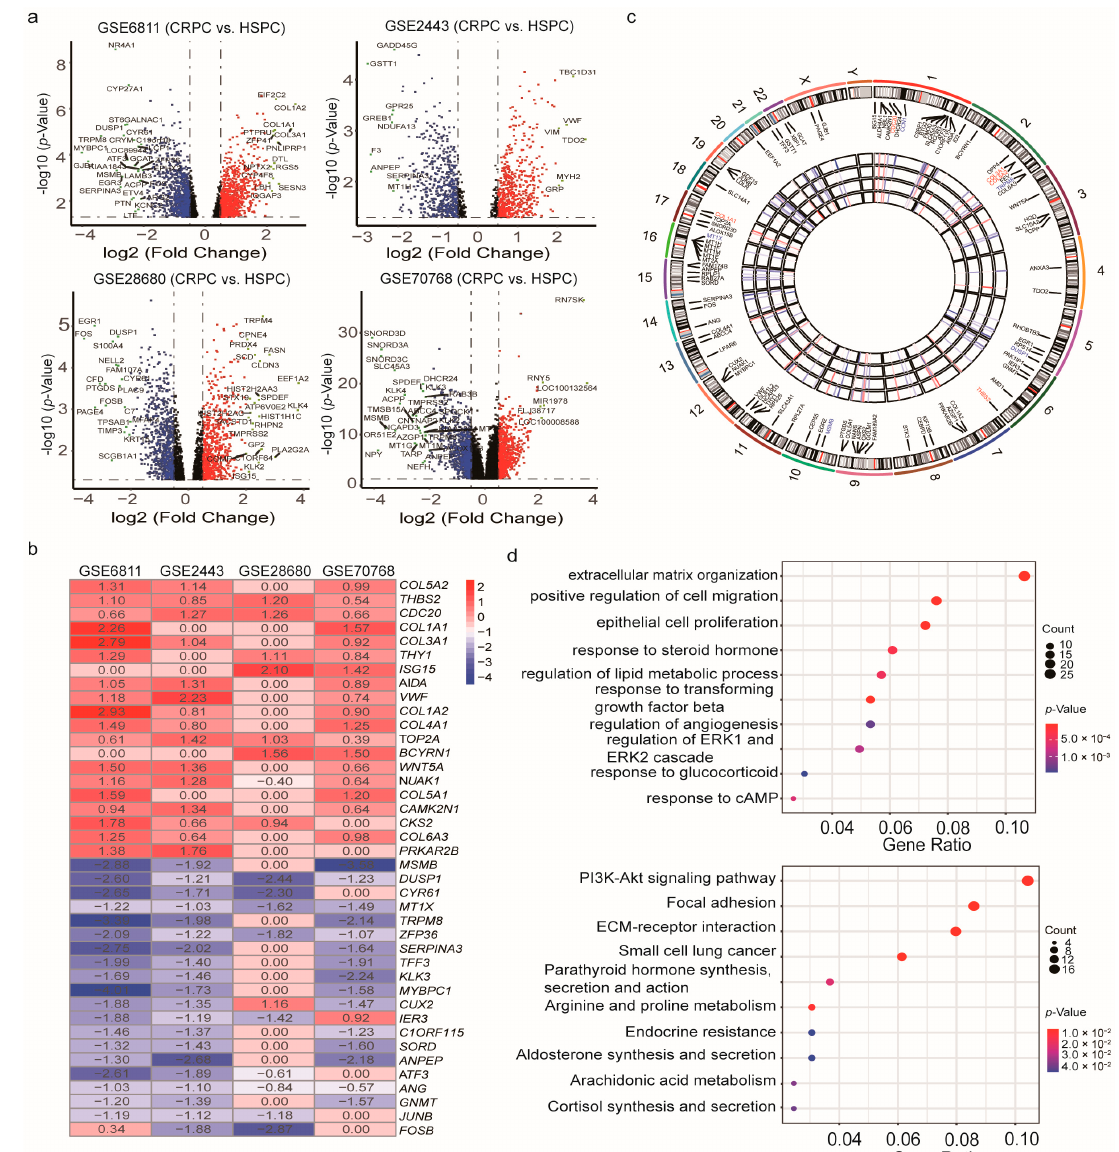
Figure 2. Identification of differentially expressed genes (DEGs) between localized CRPC and HSPC samples from 4 unrelated cohorts. ( a ) Volcano plots of datasets GSE6811 and GSE2443 (upper panel), and GSE28680 and GSE70768 (lower panel) from the GEO database. DEGs with |log2 (Fold change)| > 2 would be listed, additionally. ( b ) Heatmap of the top 20 downregulated and the top 20 upregulated genes from an integrated analysis of 4 datasets. Each column represents a dataset and each row a gene. The number in each rectangle represents the value of log2 (fold change). The gradual color ranging from blue to red represents the changing process from down- to up-regulation (CRPC vs. HSPC). ( c ) Circular visualization of expression patterns and chromosomal positions of the top 100 DEGs. The 4 prostate cancer (PCa) microarray datasets from the GEO database are represented in the inner circular heatmaps. Red, blue, and white indicate upregulated, downregulated, and absent genes in a given dataset, respectively. The outer circle represents chromosomes, and lines coming from each gene point to their specific chromosomal locations. The top five upregulated and downregulated genes ordered by p -value were marked in red and blue, respectively. ( d ) GO enrichment (upper panel) and KEGG pathway (lower panel) analyses of differentially expressed genes (DEGs) between localized CRPC and HSPC samples. CRPC: Castration-resistant prostate cancer; HSPC: Hormone-sensitive prostate cancer; GO: Gene Ontology; KEGG: Kyoto Encyclopedia of Genes and Genomes. The size of each dot represents the count of genes, and the color represents the p